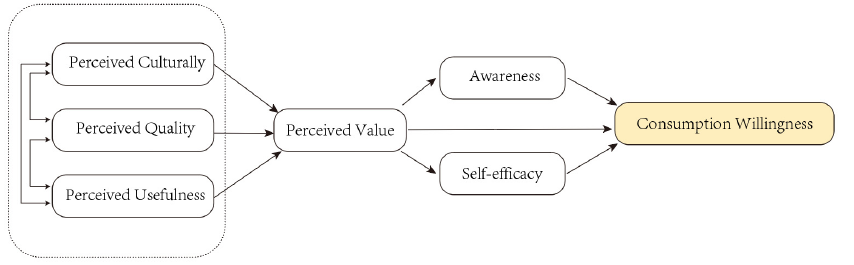
Figure 15. Consumption willingness model of Qiang embroidery cultural and creative products under the label of intangible cultural heritage.